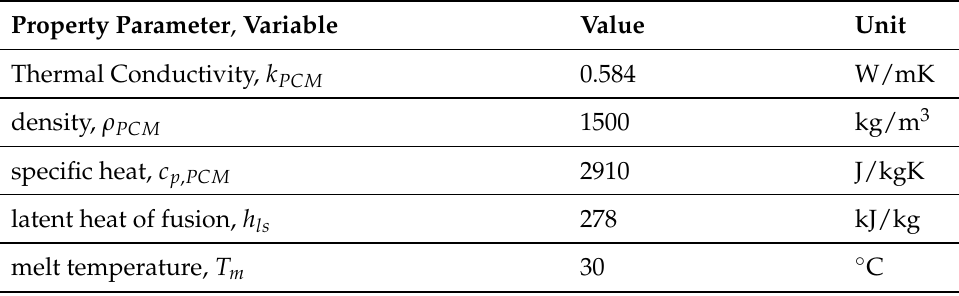
Table 2. PCM Properties: Lithium Nitrate Trihydrate.